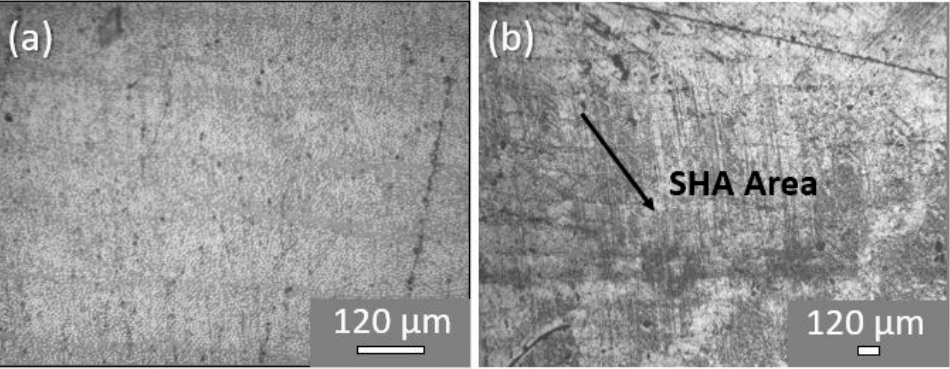
Figure 4. Representative optical microscopy images from cross-section area of ( a ) reference and ( b ) SHA-modified CFRPs (representative image).